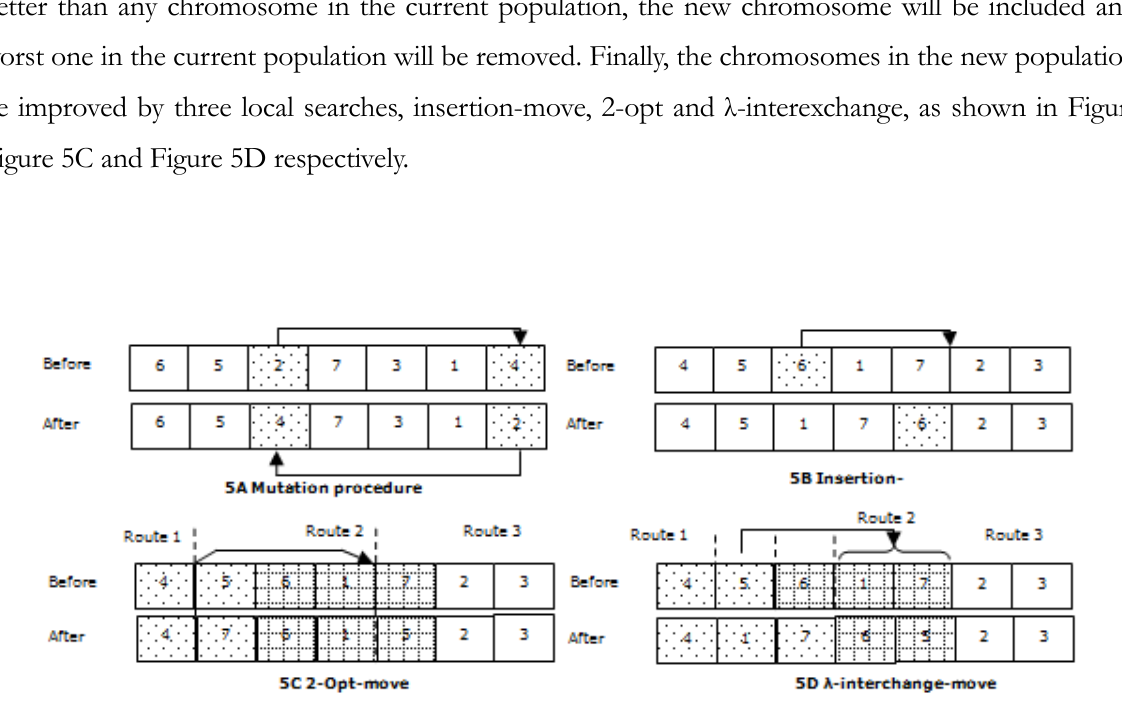
Figure 5. Mutation and three local searches (Insertion, 2-Opt and